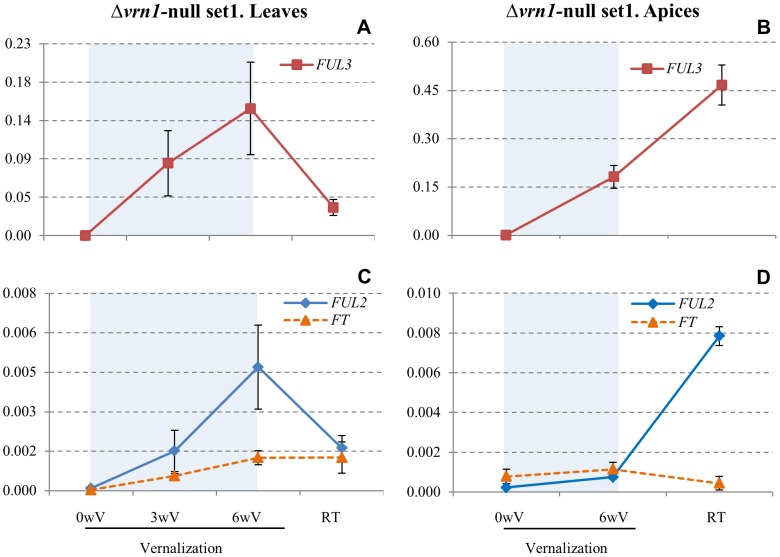
Transcriptional profiles of FUL2, FUL3, and FT during and after vernalization in the Δvrn1-null mutant set 1 (premature stop codon).A–B) FUL3, C–D) FUL2, and FT. Left panels A and C) samples from leaves. Right panels B and D) samples from apical region. The blue shaded area indicates vernalization at 4°C under long days. 0 wV: 3 weeks-old plants grown at 22°C/17°C (day/night) immediately before vernalization, 3 wV: 3 weeks of vernalization, 6 wV: 6 weeks of vernalization, RT: two weeks after removing the plants from the cold and returning them to pre-vernalization conditions. The X axis scale is not proportional to time and the Y scale is in fold-ACTIN values. Error bars are SE of the means from 8 biological replications in the leaves and 3 biological replications in the apices (each including a pool of 30 shoot apical meristem and surrounding tissue).